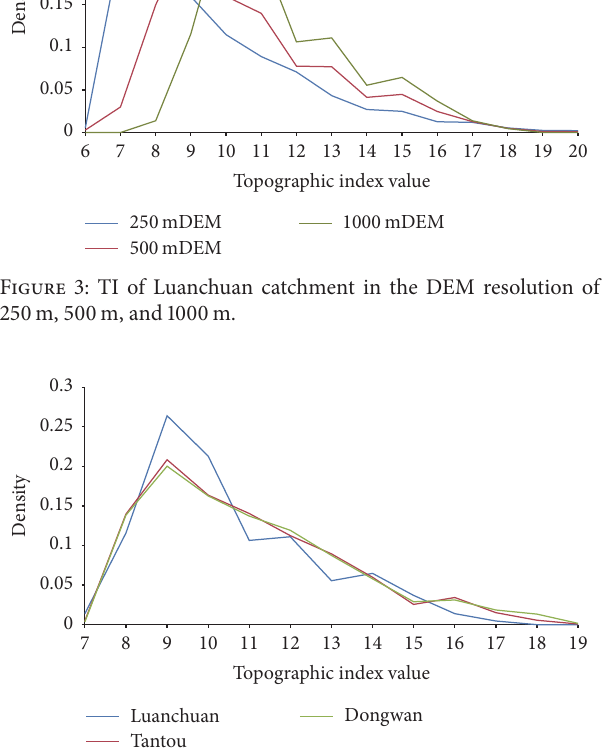
Figure 4: TI of the nested catchment consists of Dongwan, Tantou, and